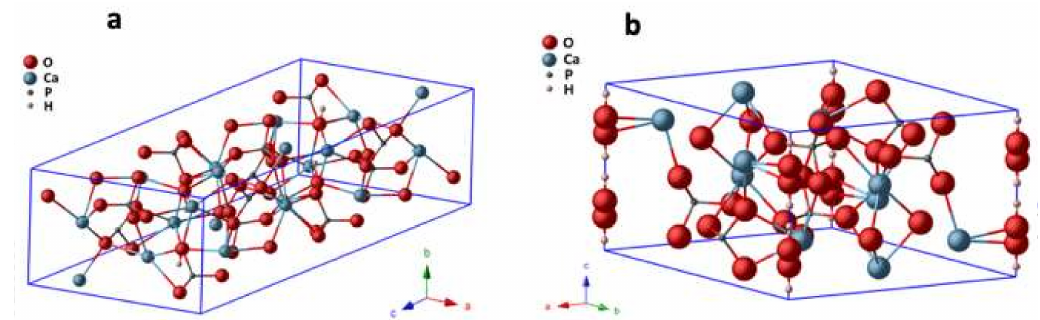
Figure 1. ( a ) Monoclinic and ( b ) hexagonal unit cell of HA at 298 K and 673 K, respectively, according to the results obtained by powder X-ray diffraction by using synchrotron radiation